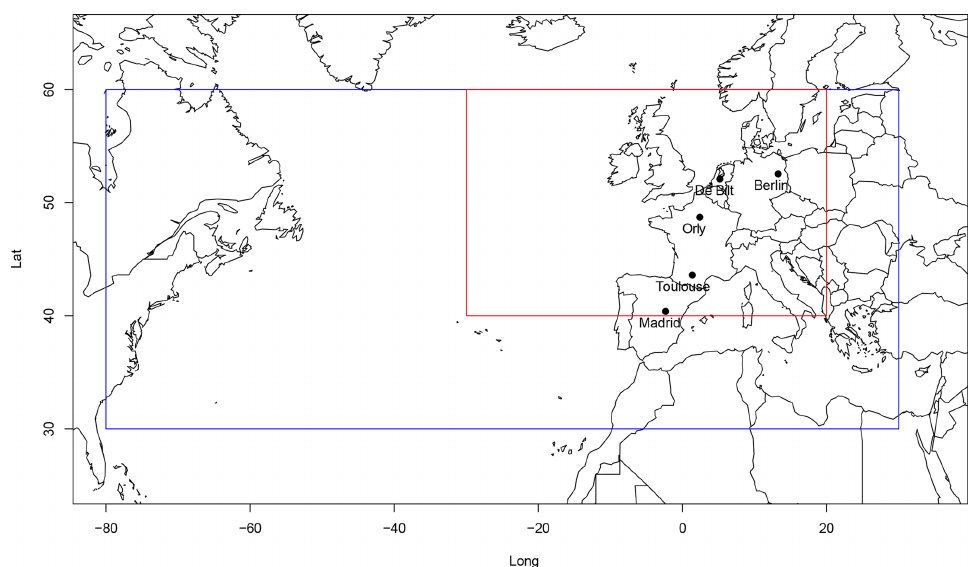
Figure 1. Upper panel: North Atlantic region (blue rectangle) and western European region (red rectangle) on which analogues are computed.